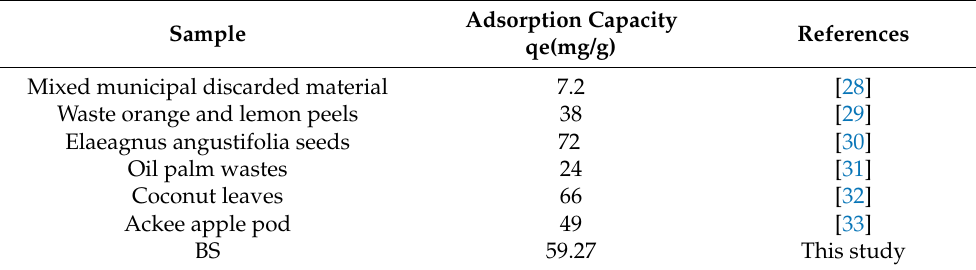
Figure 4. Maximum MB adsorption capacity (mg/g) of KBS at 40 °C and pH 7 . Table 4. Adsorption capacities of waste adsorbents reported in literature.